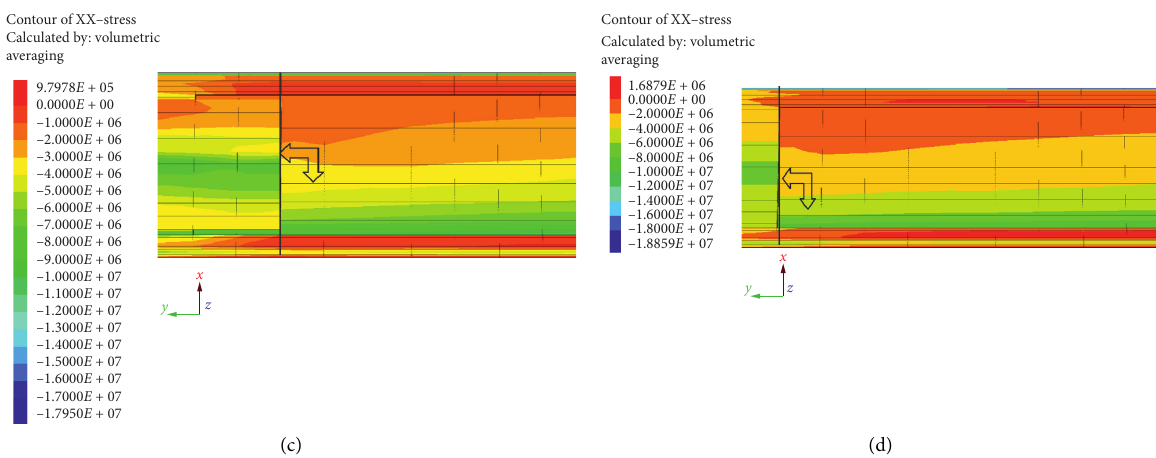
Figure 13: Advanced horizontal stress cloud diagram of the third left working face. (a) The working face is advanced by 100m. (b) The working face is advanced by 200m. (c) The working face is advanced by 300m. (d) The working face is advanced by 400m.